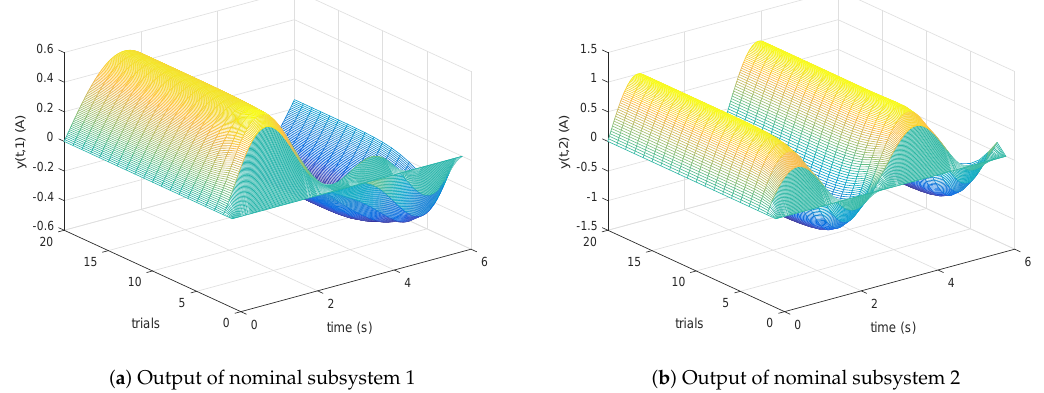
Figure 3. Outputs of nominal subsystems 1 and 2.